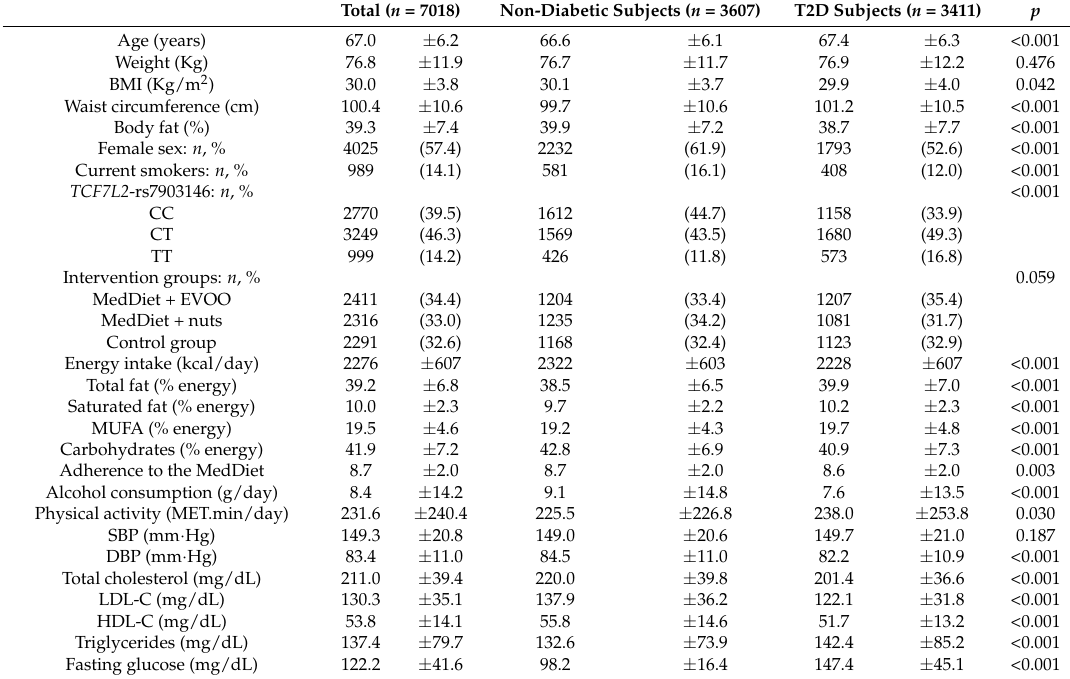
Table 1. Demographic, clinical, lifestyle, and genetic characteristics of the study participants at baseline according to the diabetes